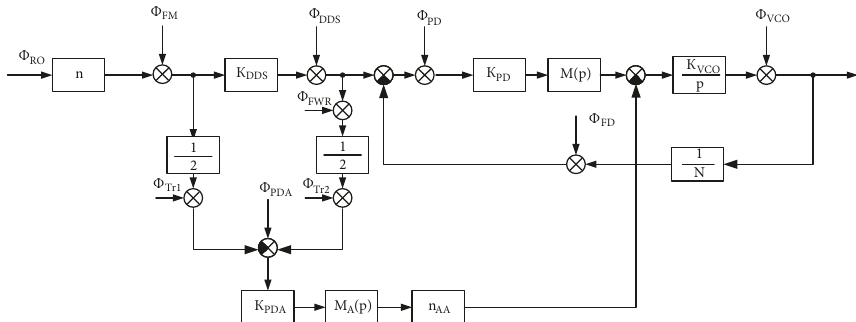
Figure 7: Equivalent circuit of the channel for forming signals with the DDS as a reference oscillator of the PLL with all sources of phase noises.